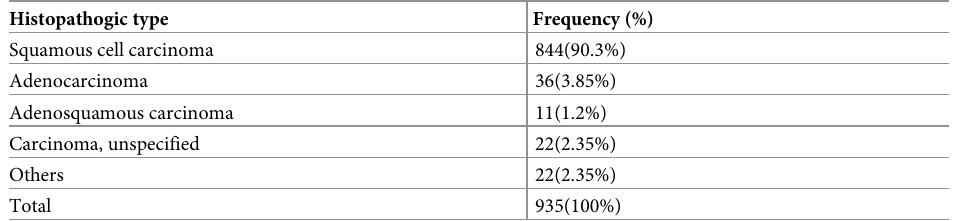
Table 3. Histopathological classification of cervical cancer, 2014–18, SPHMMC.